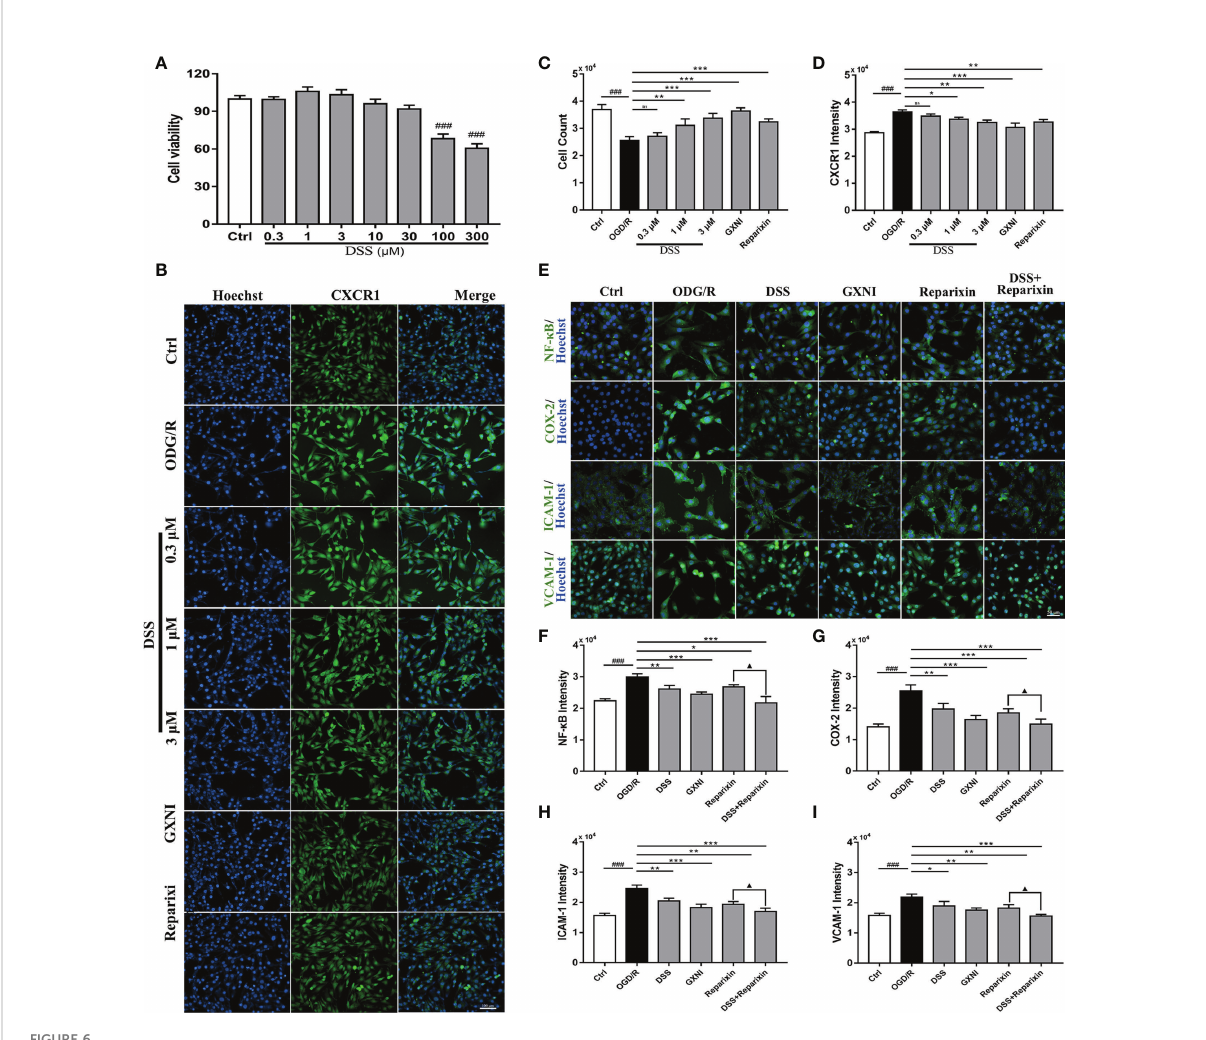
FIGURE 6 DSS inhibited the expression of NF- k B, COX-2, ICAM-1 and VCAM-1 in HL-1 cells after OGD/R. (A) Bar graph quantitation of DSS on the viability of HL-1 cells. After OGD/R, the protective effect of DSS on HL-1 cells and its effect on the expression of CXCR1 protein were evaluated by immunocyto fl uorescence. (B) Representative images of each group, in which the nuclei were stained in blue by Hoechst and the CXCR1 protein was stained green. Scale bar = 100 µm. (C) Bar graph quantitation of the number of cells in each group. (D) Quanti fi cation of the average fl uorescence intensity of CXCR1 in each group. (E) Representative images of each group. The nucleus was stained blue, and NF- k B, COX-2, ICAM-1 and VCAM-1 were labeled green. Scale bar = 50 µm. (F) Quanti fi cation of the average fl uorescence intensity of NF- k B in each group. (G) Quanti fi cation of the average fl uorescence intensity of COX-2 in each group. (H) Quanti fi cation of the average fl uorescence intensity of ICAM-1 in each group. (I) Quanti fi cation of the average fl uorescence intensity of VCAM-1 in each group. Values were expressed as mean ± SD (n = 3). ### P < 0.001 vs. Ctrl group; * P < 0.05, ** P < 0.01, *** P < 0.001 vs. OGD/R group; ▲ P < 0.05 vs. Reparixin group. ns: no signi fi